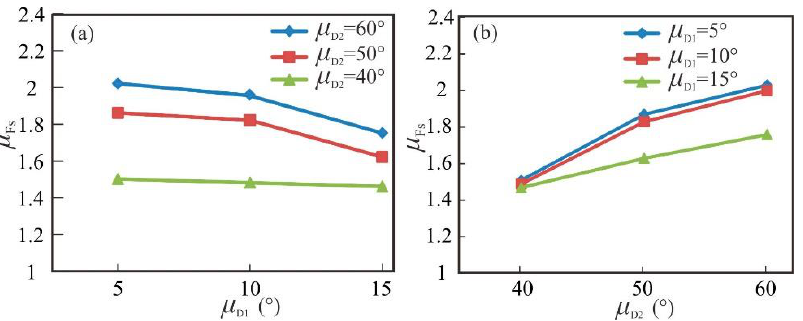
 with  increases; b-the  (a-the change of Figure 9. Influence of fracture dip on µ Fs (( a )—the change of µ Fs with µ D increases; ( b )—the change Figure 9. Influence of fracture dip on Fs Fs 1 1 D of µ Fs with µ D increases). Note: γ is the ratio of µ D to µ D  increases). Note:  is the ratio of  to  . 2 2 1 change of Fs  with 2 D 2 D 1 D